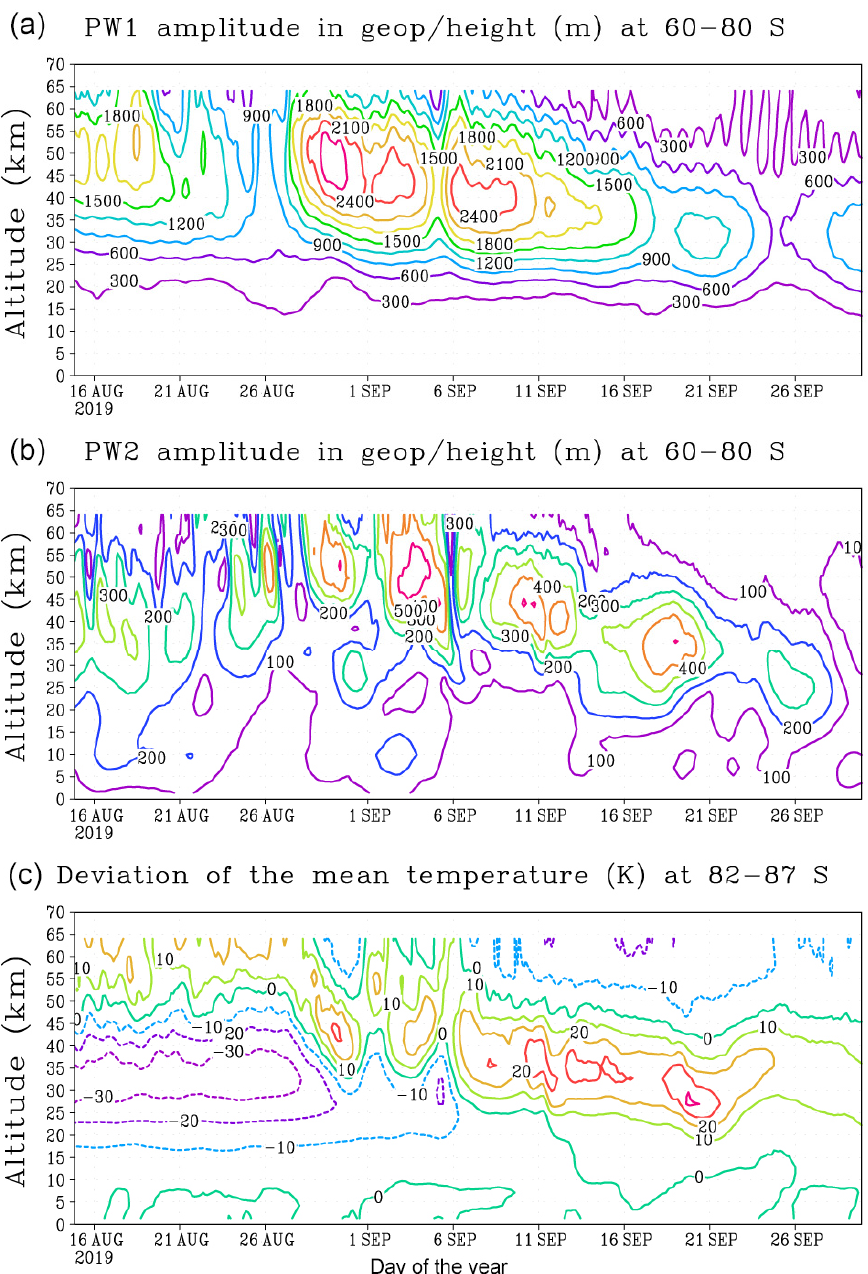
Figure 6. ( a ) Time series of PW1 amplitude between 60° and 80° S. ( b ) the same but for the PW2 amplitude. ( c ) deviation from the average (August–September) zonal-mean temperature (K).